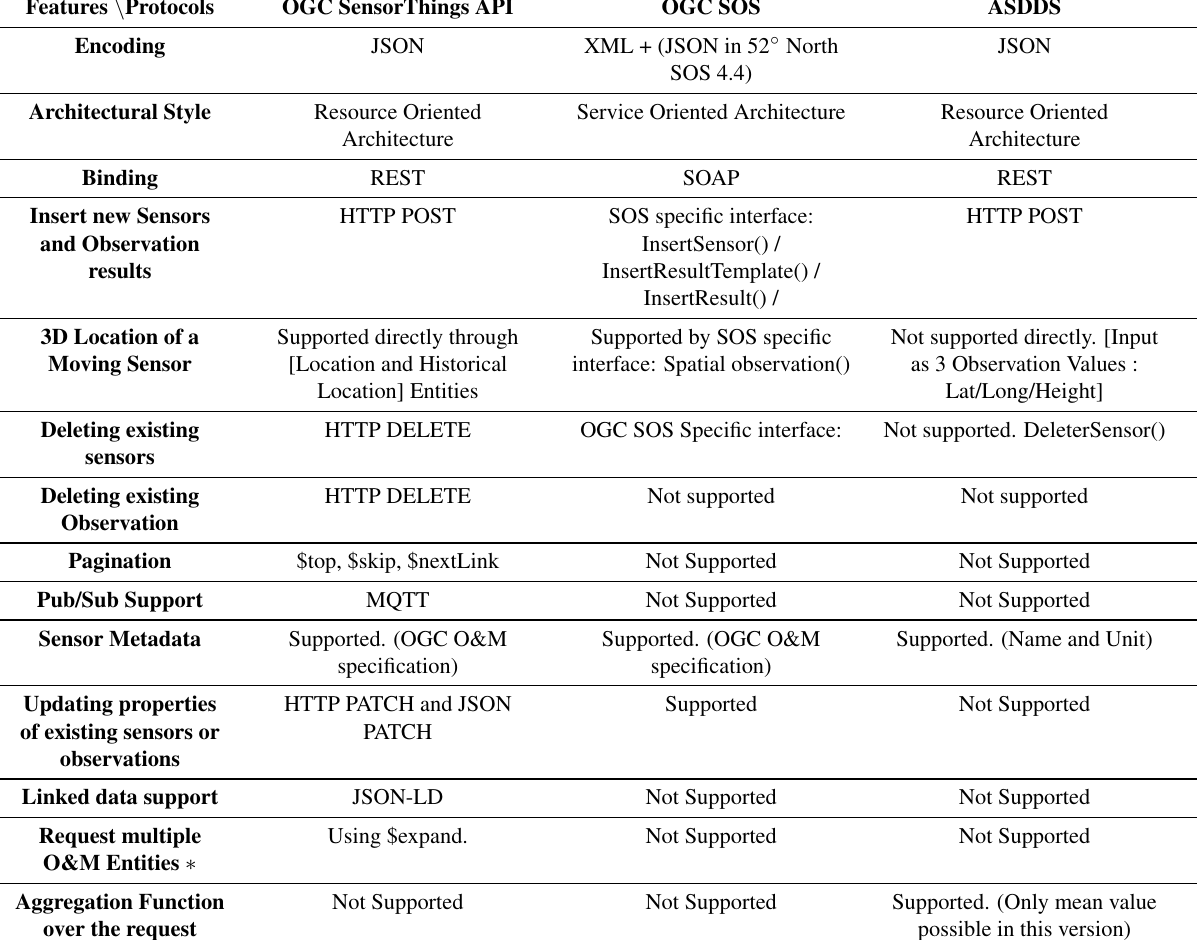
Table 1: Sensor protocol features